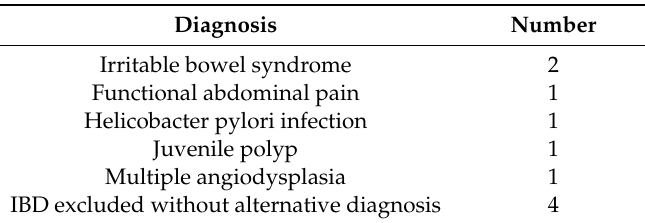
Table 2. Diagnoses